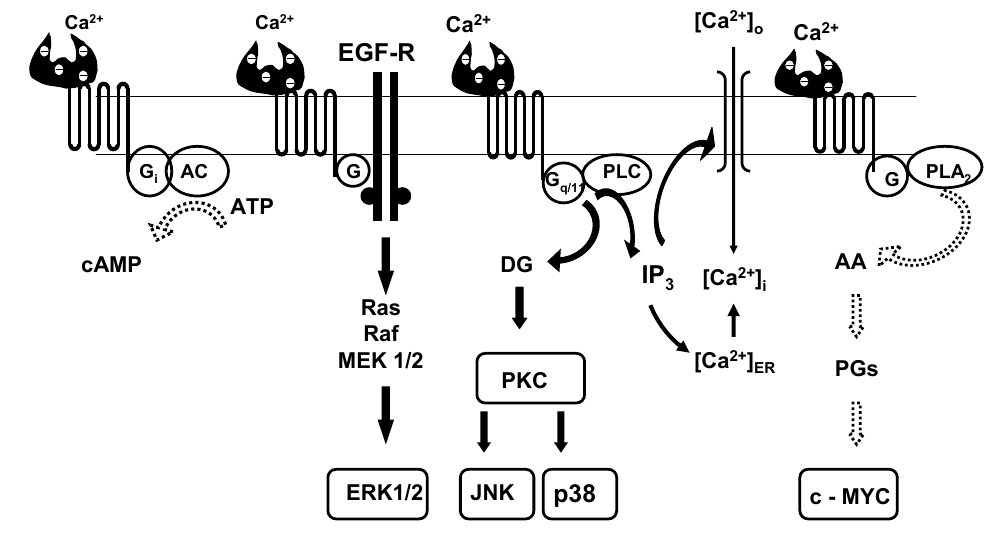
Figure 1. The extracellular calcium-sensing receptor (CaSR) senses, amplifies and transduces minute variations in [Ca 2+ ] into various intracellular signaling pathways. Bold o arrows indicate coupling to stimulatory G proteins, dotted arrows indicate coupling to inhibitory G proteins. Only cell-specific pathways relevant for the diseases mentioned in the text are shown (for more details on CaSR-activated pathways, see Magno et al.